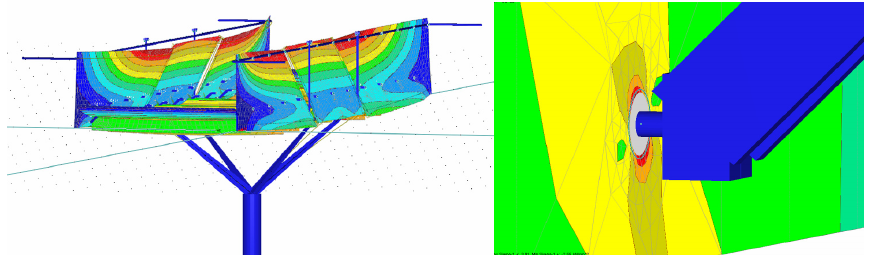
Figure 2: Buckling analysis (left) and local stress analysis (right)